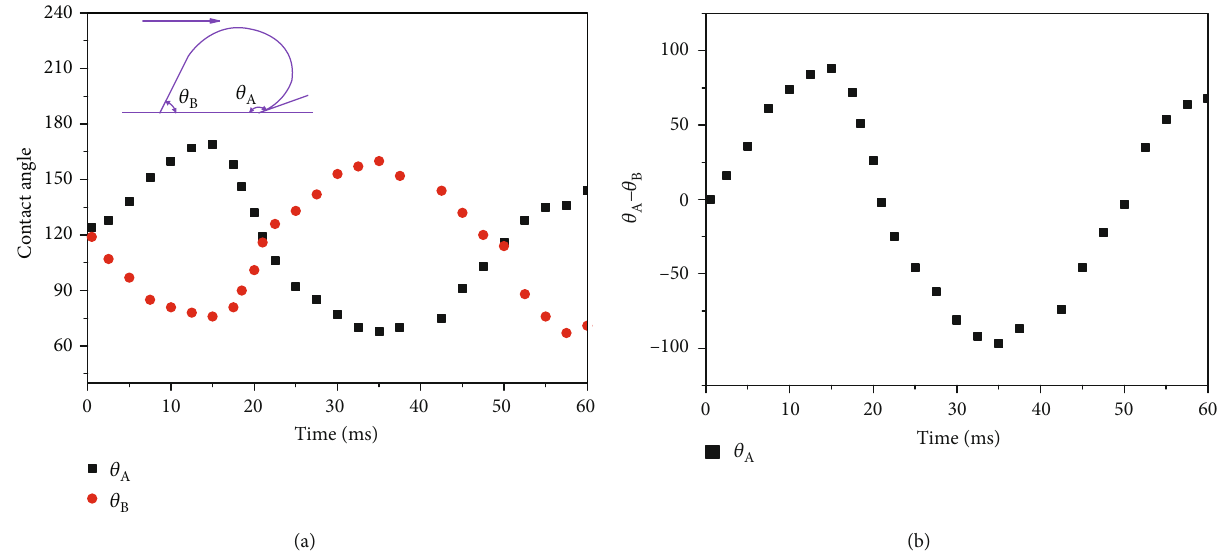
Figure 11: The variation of the droplet with time at the frequency of 20Hz and the amplitude of 1mm: (a) contact angle and (b) contact angle hysteresis.